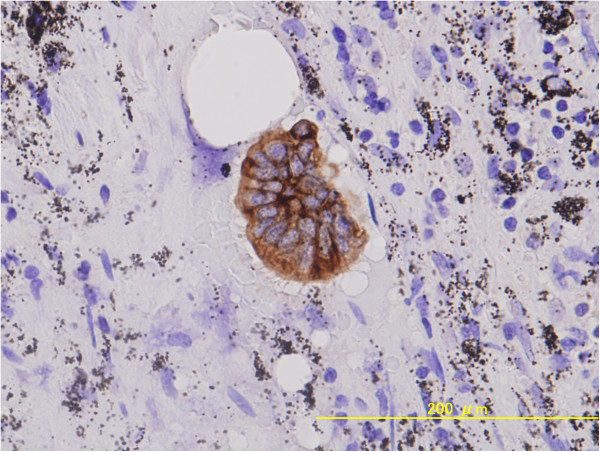
Isolated tumor cells in a dissected lymph node. Isolated tumor cells were detected by immunostaining using anti-cytokeratin antibody in a patient diagnosed with MIA. The patient’s pathological stage was pT1aN(i+)M0, Stage IA.